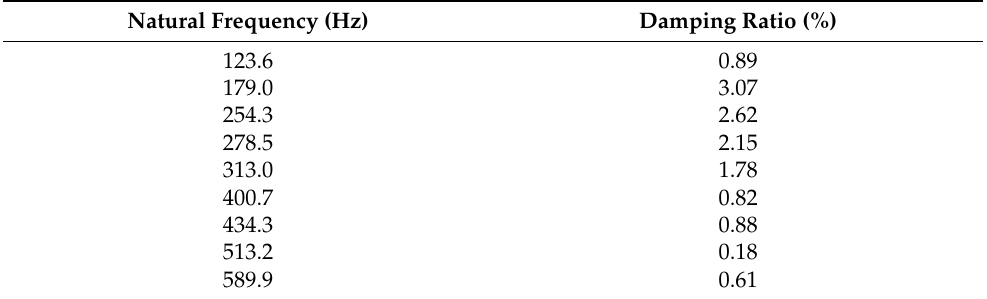
Figure 7. Stabilization diagram obtained by applying LMS operational polyreference least-squares complex frequency-domain method (PolyMAX). Table 1. Natural frequency and damping ratio of the CFRP aeronautical panel using operational modal analysis